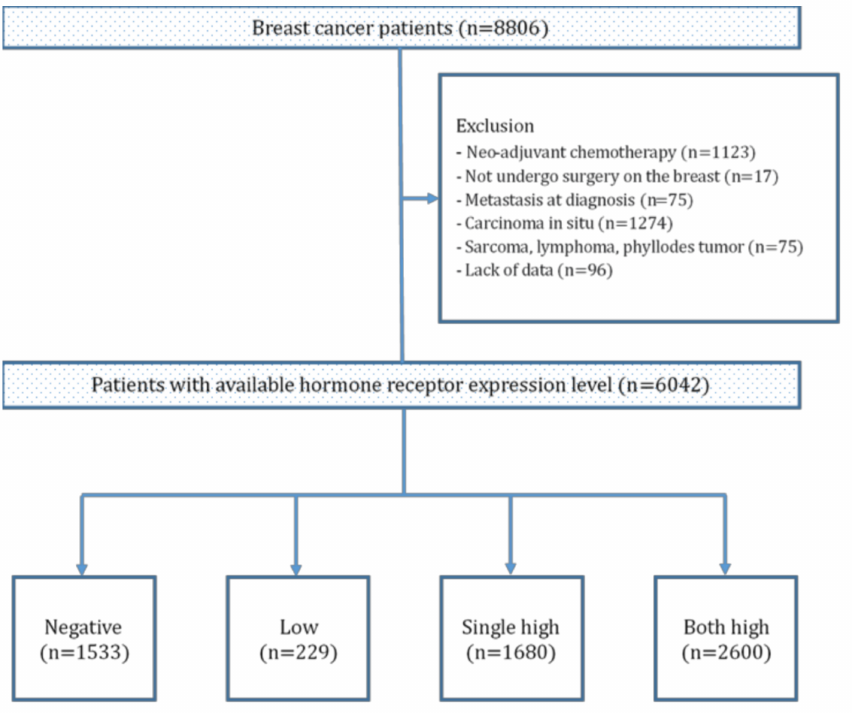
Figure 1. Schematic representation of the process of patient